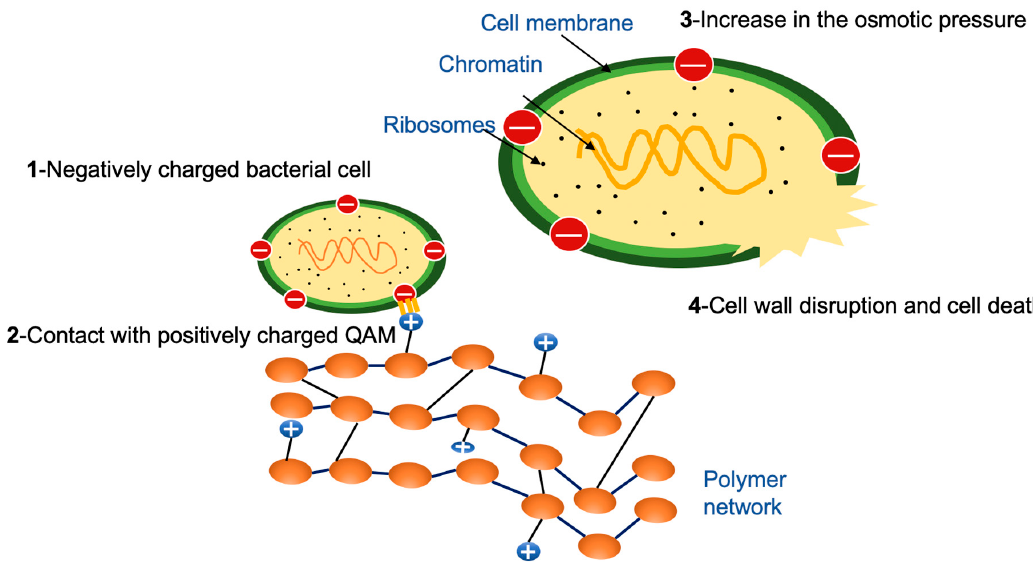
Figure 9. The antibacterial mechanism of DMAHDM. When the positively charged sites (N + ) of DMAHDM contacts the negatively charged bacterial cell membrane, the electric balance of the cell membrane could be disturbed, leading to cytoplasmic leakage and bacterial cell death.